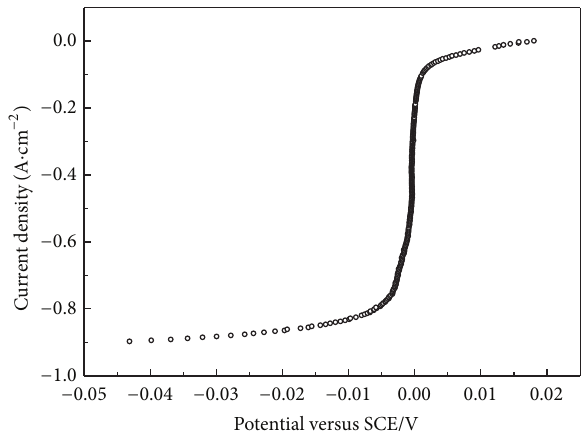
Figure 3: Polarization curve (current density versus applied poten-